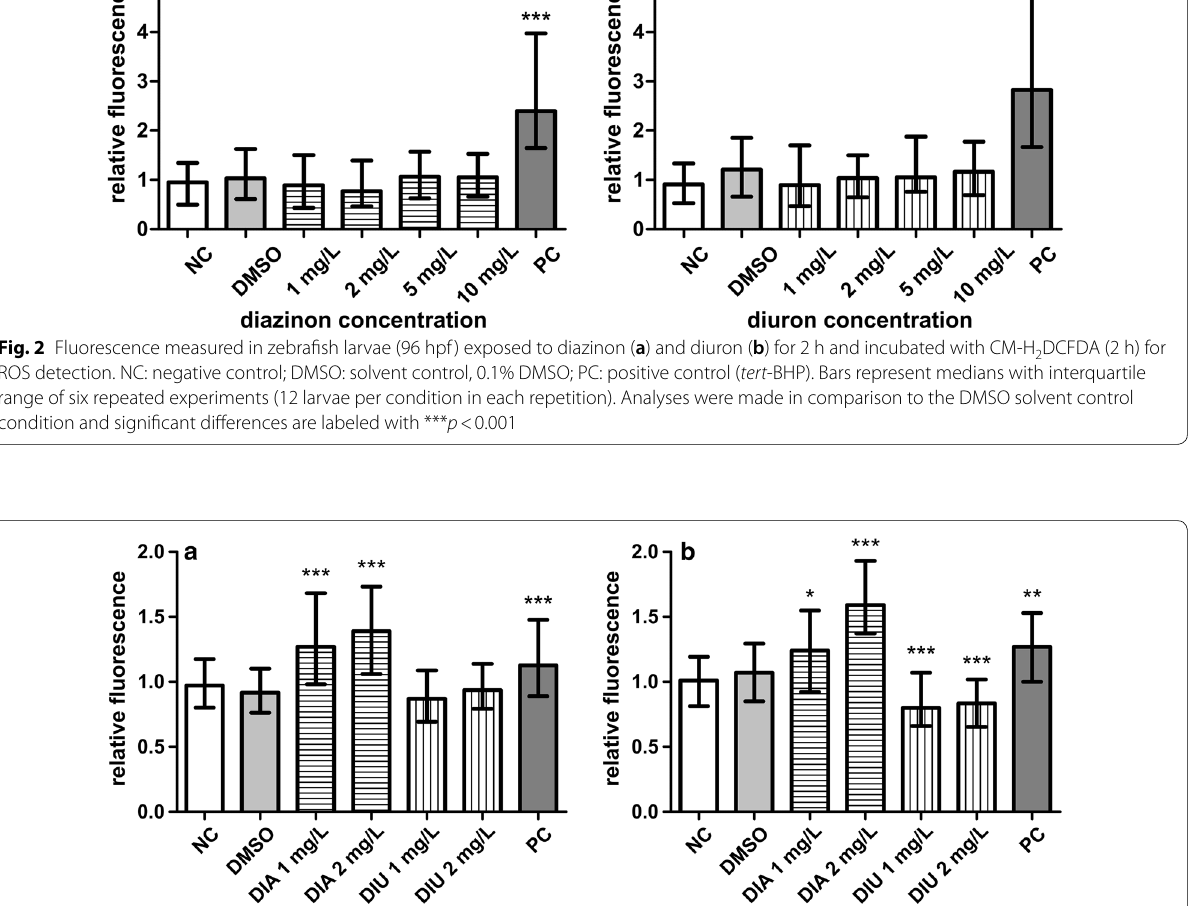
Fig. 3 Fluorescence measured in zebrafish embryos exposed to diazinon and diuron for 24 h ( a ) and 48 h ( b ) and incubated with rhodamine B (90 min) for MXR activity assessment. NC: negative control; DMSO: solvent control, 0.1% DMSO; DIA: diazinon; DIU: diuron; PC: positive control (CYC). Bars represent medians with interquartile range of five repeated experiments (12 embryos per condition in each repetition). Analyses were made in comparison to the DMSO solvent control condition and significant differences are labeled with * p < 0.05, ** p < 0.01 and *** p <